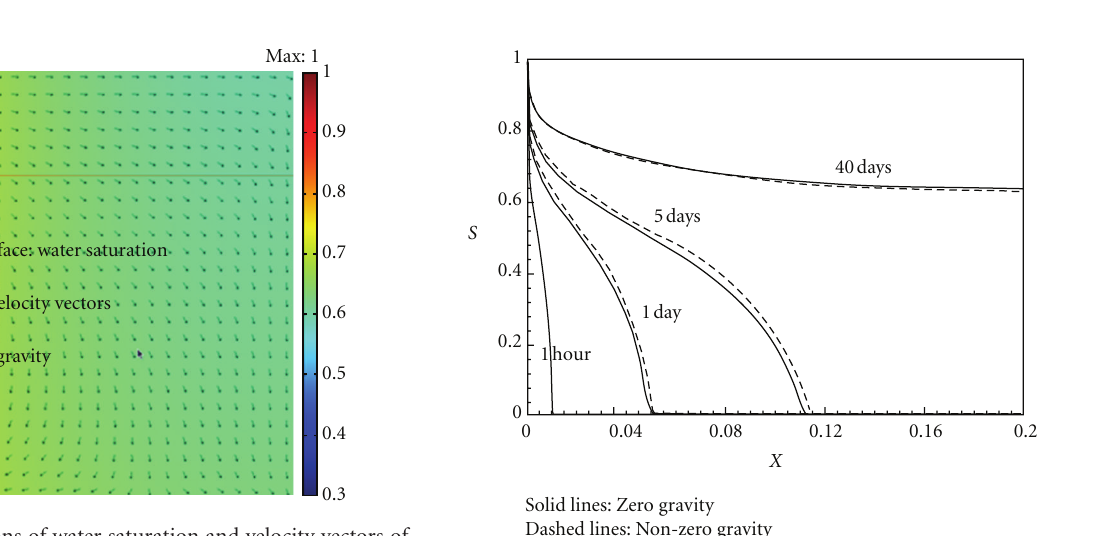
Figure 3: Distributions of water saturation and velocity vectors of nonzero gravity of Case A, at time imbibition of 40 days.